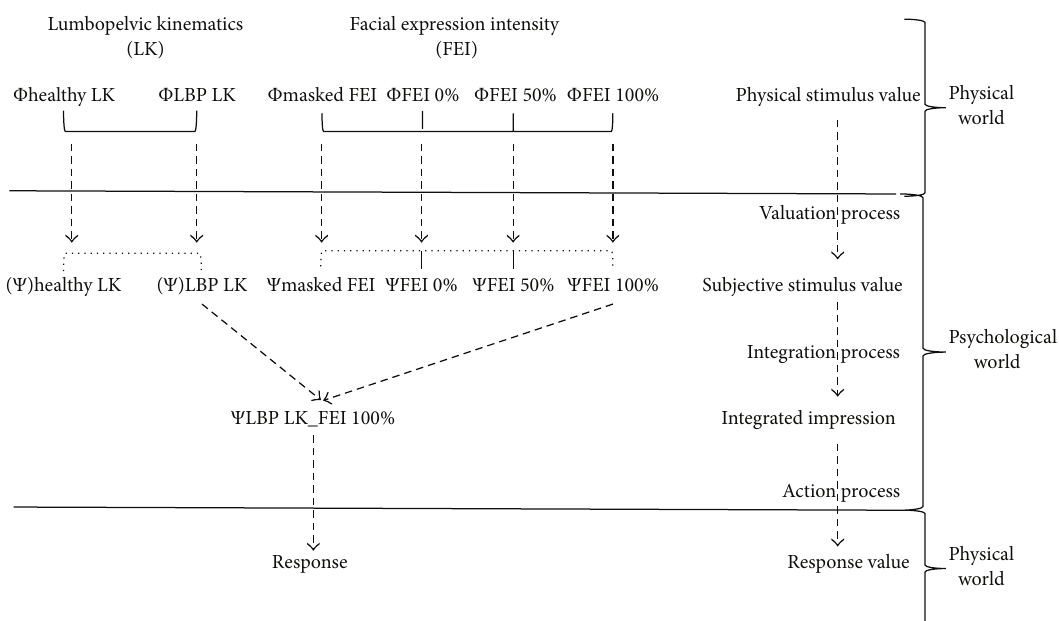
Figure2:IllustrationofAnderson’s[5]InformationIntegrationTheoryappliedtothisexperiment:fromstimuluspresentationtoparticipants’